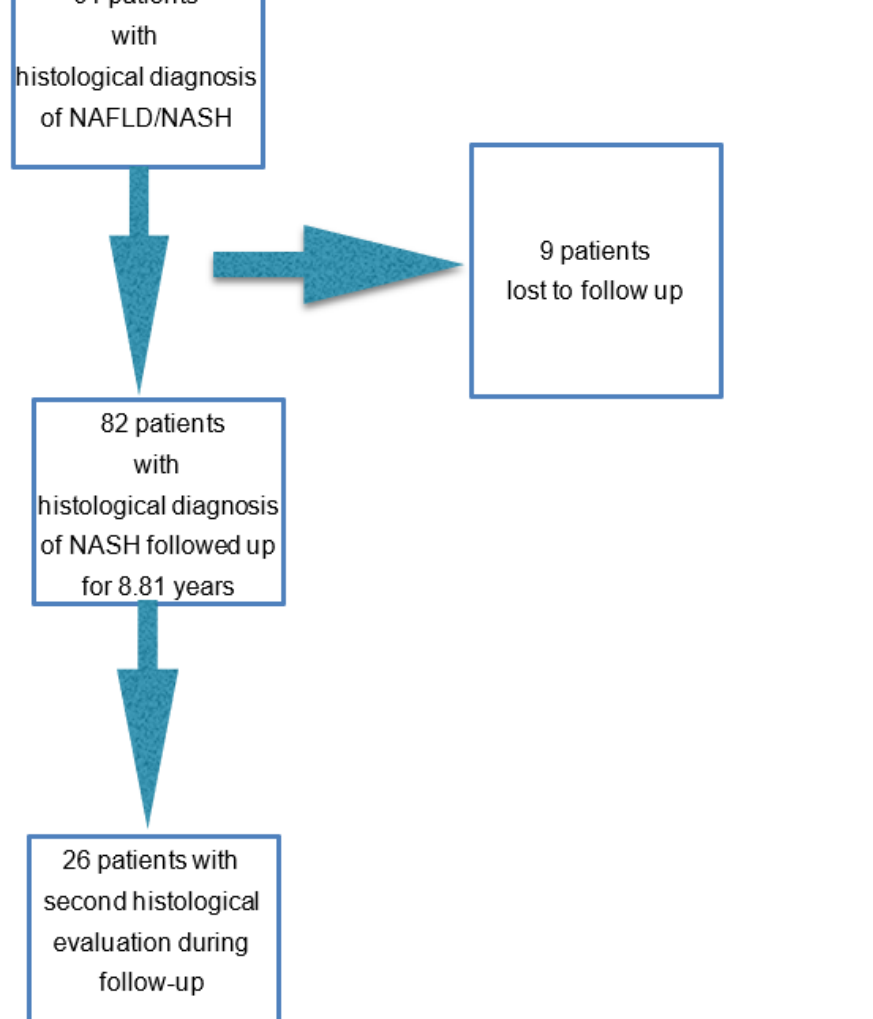
Figure 1. Study flow chart showing the number of patients initially included, the number of sub- jects lost to follow up and the number of patients with paired biopsies. (NAFLD = Non-Alcoholic fatty liver disease; NASH = Non-alcoholic steatohepatitis)